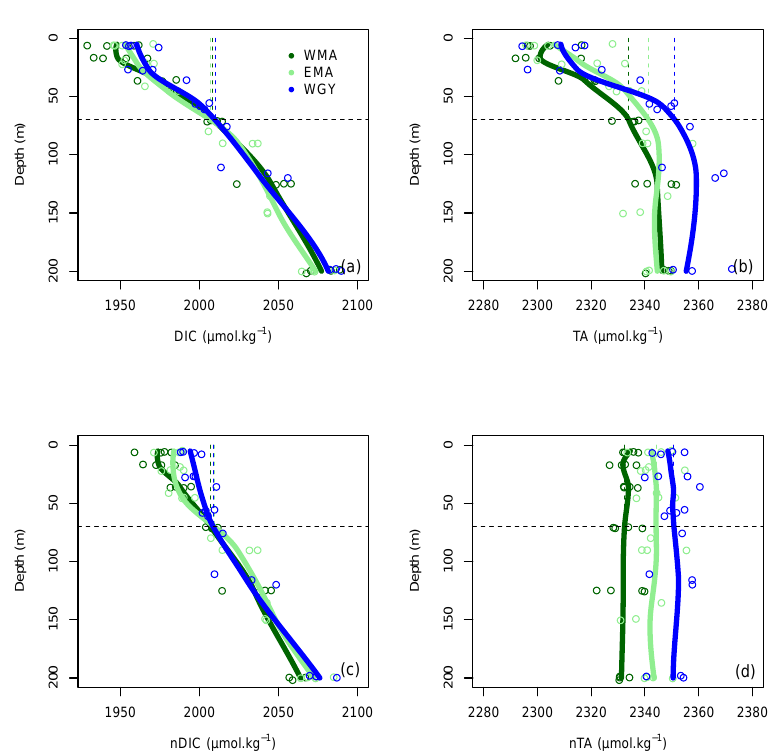
Figure 4. Vertical profiles of (a) dissolved inorganic carbon (DIC), (b) total alkalinity (TA), (c) normalized dissolved inorganic carbon (nDIC), and (d) normalized total alkalinity (nTA) against depth (m) for the three distinct areas sampled during the OUTPACE cruise: the western Melanesian Archipelago (WMA in dark green), the eastern Melanesian Archipelago (EMA in light green), and the western SP gyre (WGY in blue). The horizontal dashed lines indicate the mixed layer depth of 70m. The vertical dashed lines indicate the upper surface expected values for all variables during the 2014 austral